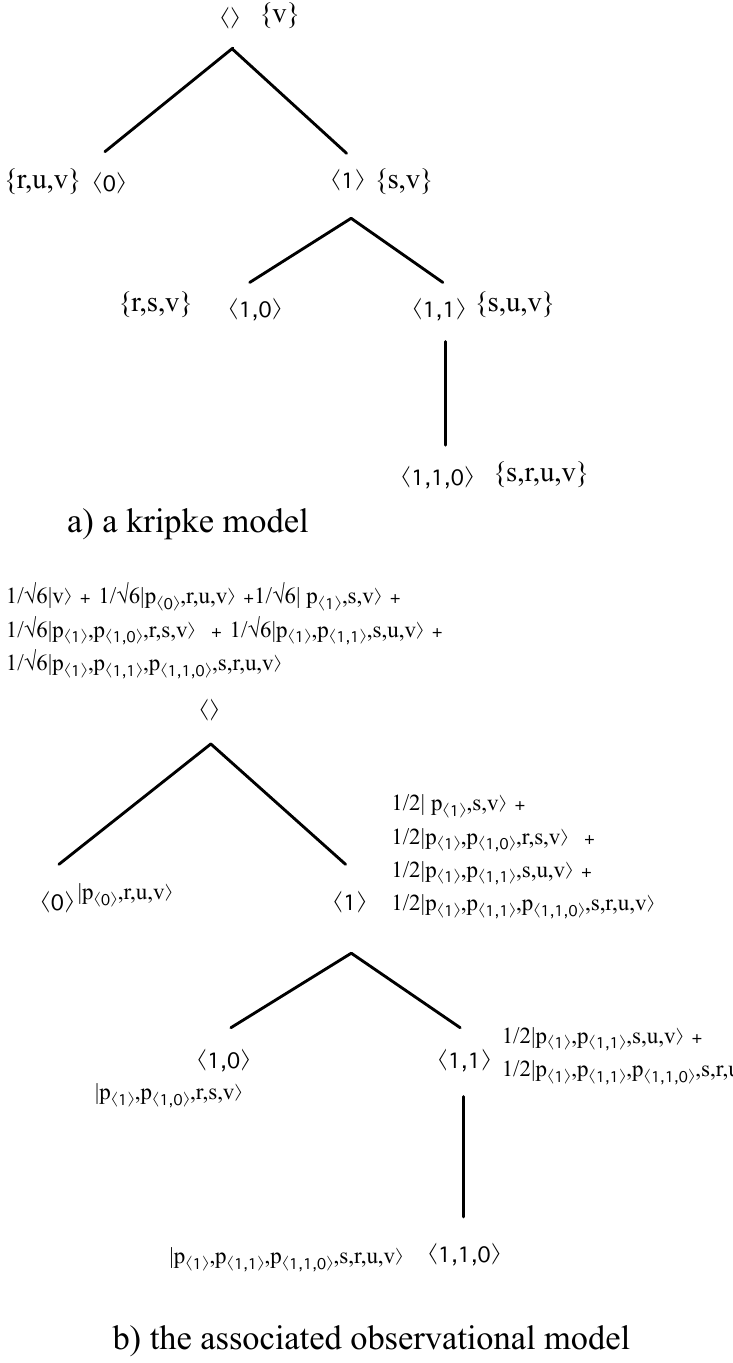
Figure 2. The transformation of a Kripke model in a observational